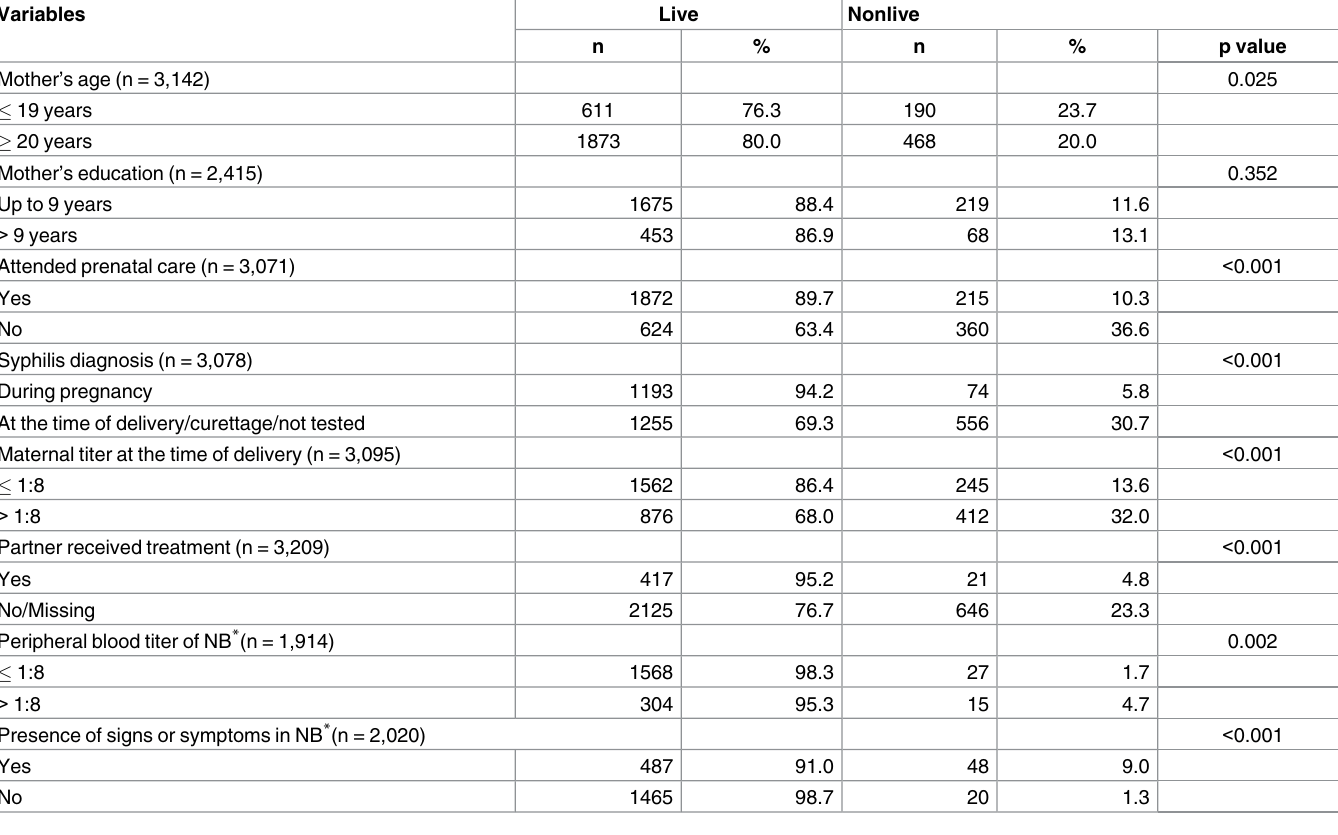
Table 2. Maternal and other factors associatedwith CS death or CS live infant, Fortaleza–Ceara´,